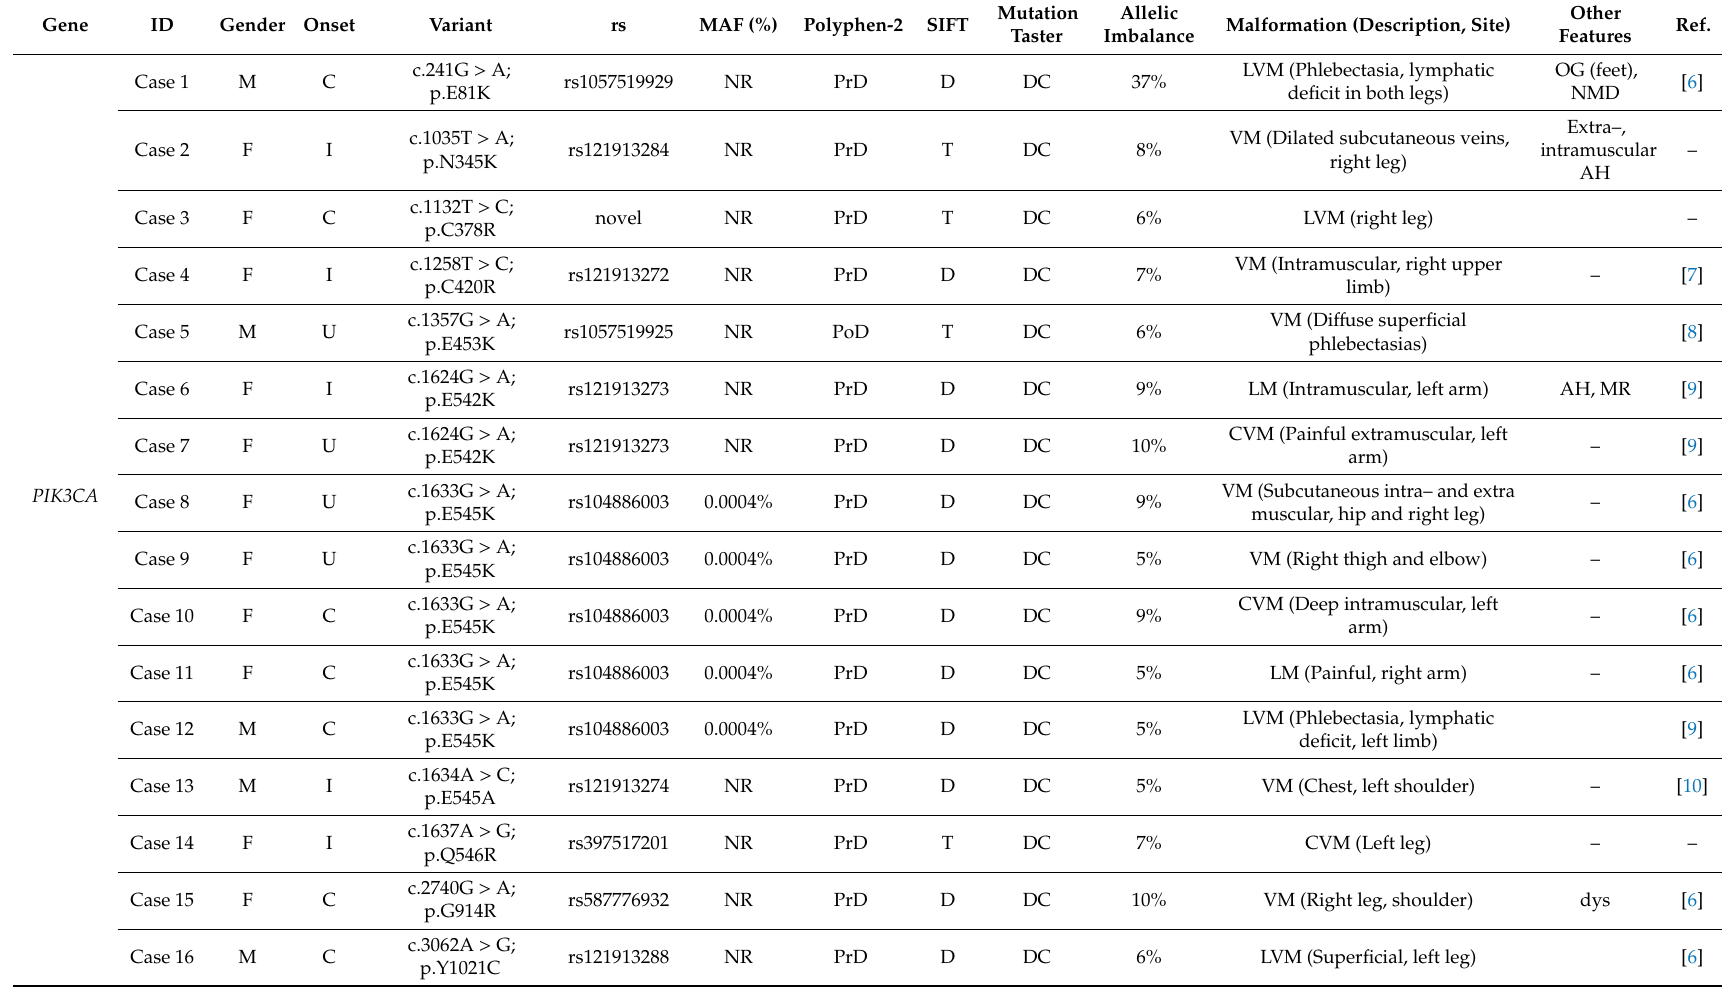
Table 2. Somatic pathogenic variants identified in positive cases, with allelic imbalance and clinical